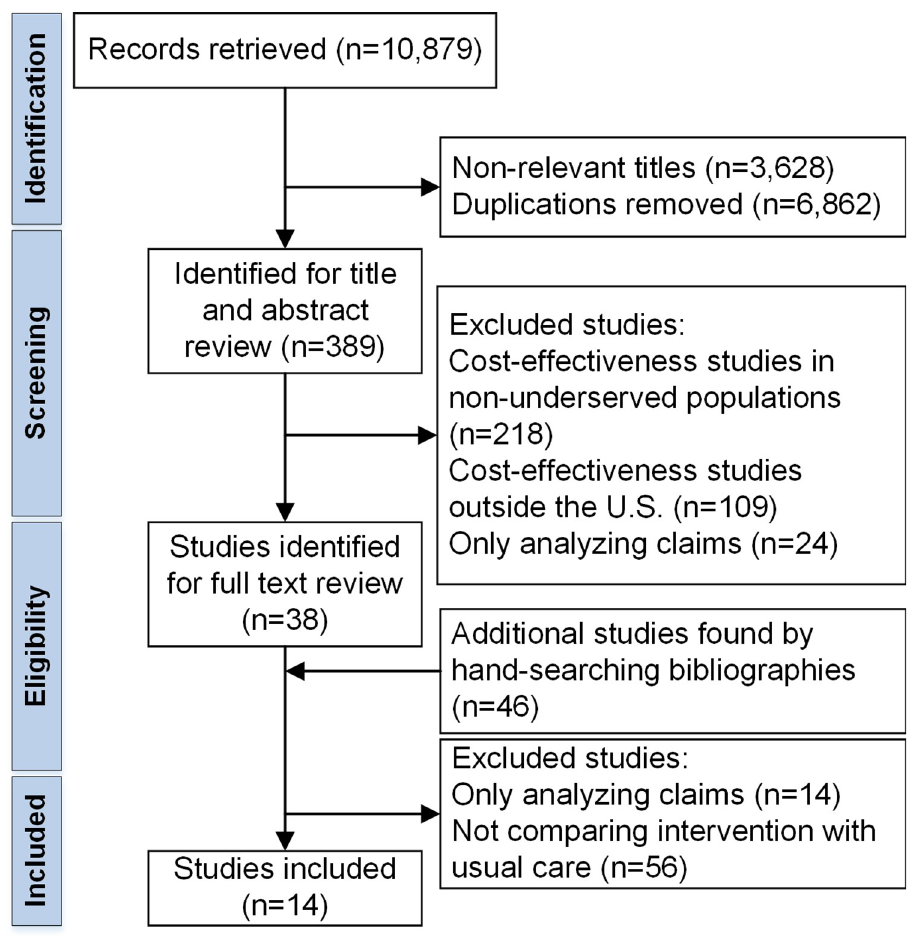
Fig 1. PRISMA flow